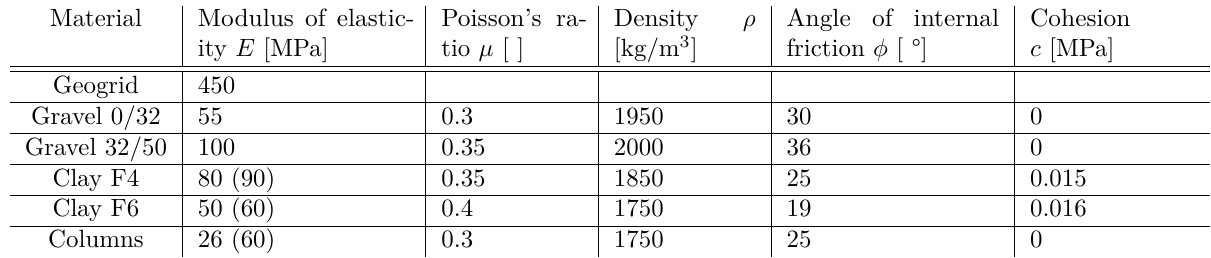
Table 1. Material properties of each layer of the model type 1 and (type 2).